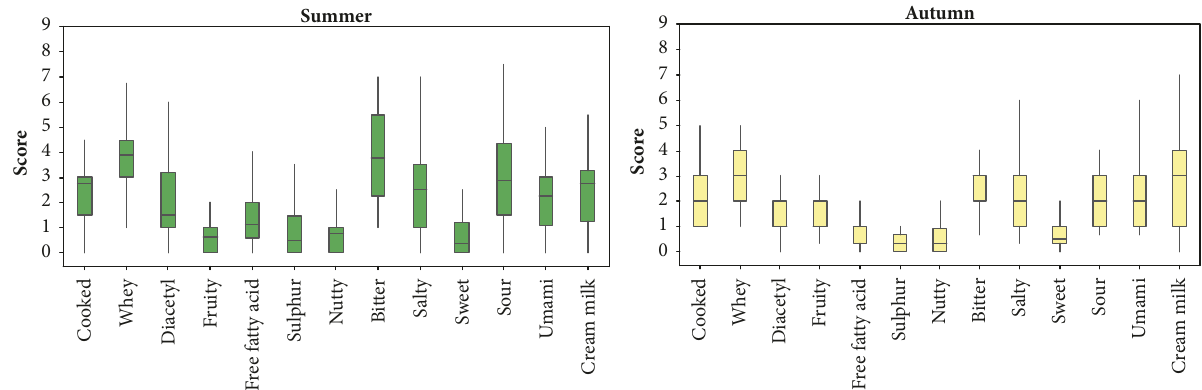
Figure 1: Boxplot of Quantitative Descriptive Analysis of Chihuahua cheese manufactured with raw milk and sampled during summer and autumn. Median, 1 st and 3 rd quartile, minimum, and maximum scores are presented for each descriptor.